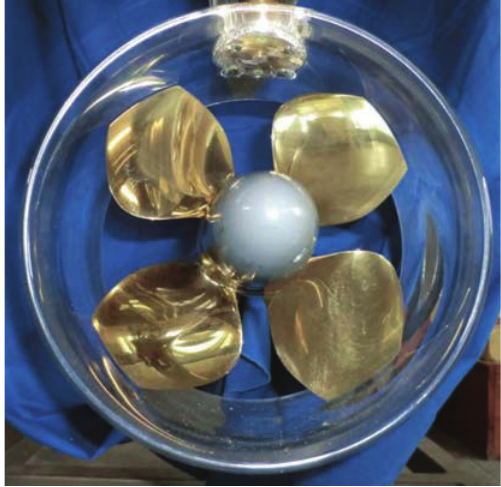
Figure 10: Ducted propeller model.